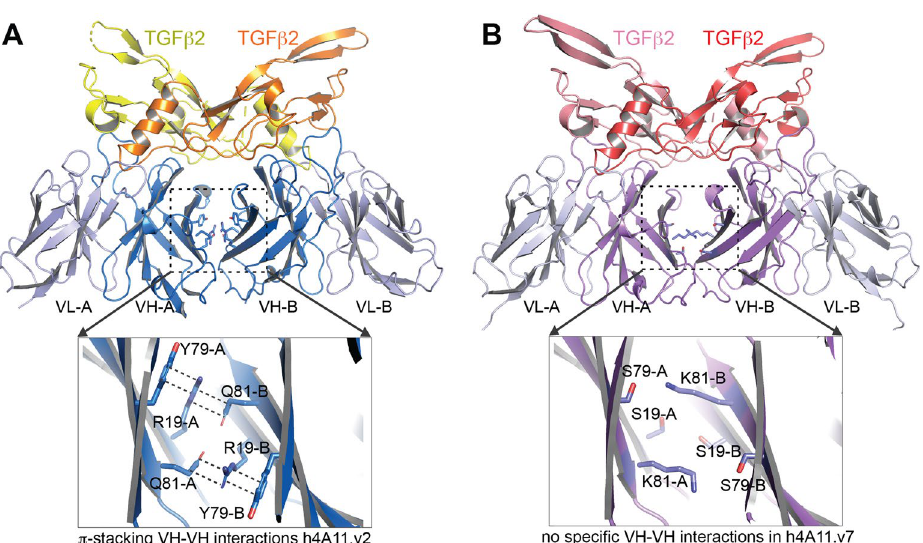
Figure 4. Molecular interactions between h4A11.v2 and h4A11.v7 Fabs bound to TGFβ2. ( A ) π-stacking between Y79 and R19 from one heavy chain A and Q81 from the second heavy chain B and vice versa results in a stable interaction between the two heavy chains of the Fabs in the h4A11.v2:TGFβ2 complex. ( B ) Aforementioned π-stacking is disrupted in h4A11.v7:TGFβ2 complex because of the substitution in the framework region of the heavy chain residues to S79, S19 and